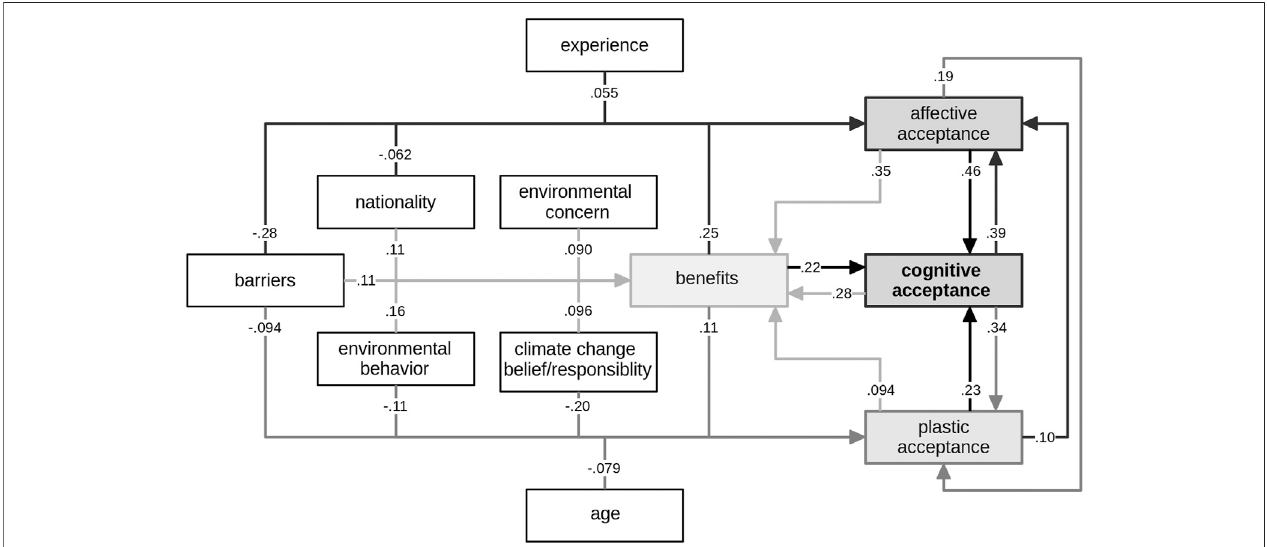
FIGURE 6 | The visualization of the combined results of the step-wise multiple linear regressions for the complete dataset ( N (cid:1) 643). The values on the arrows indicate the standardized beta coef fi cient of the respective relationship, as can also be found in Table 2 – 5